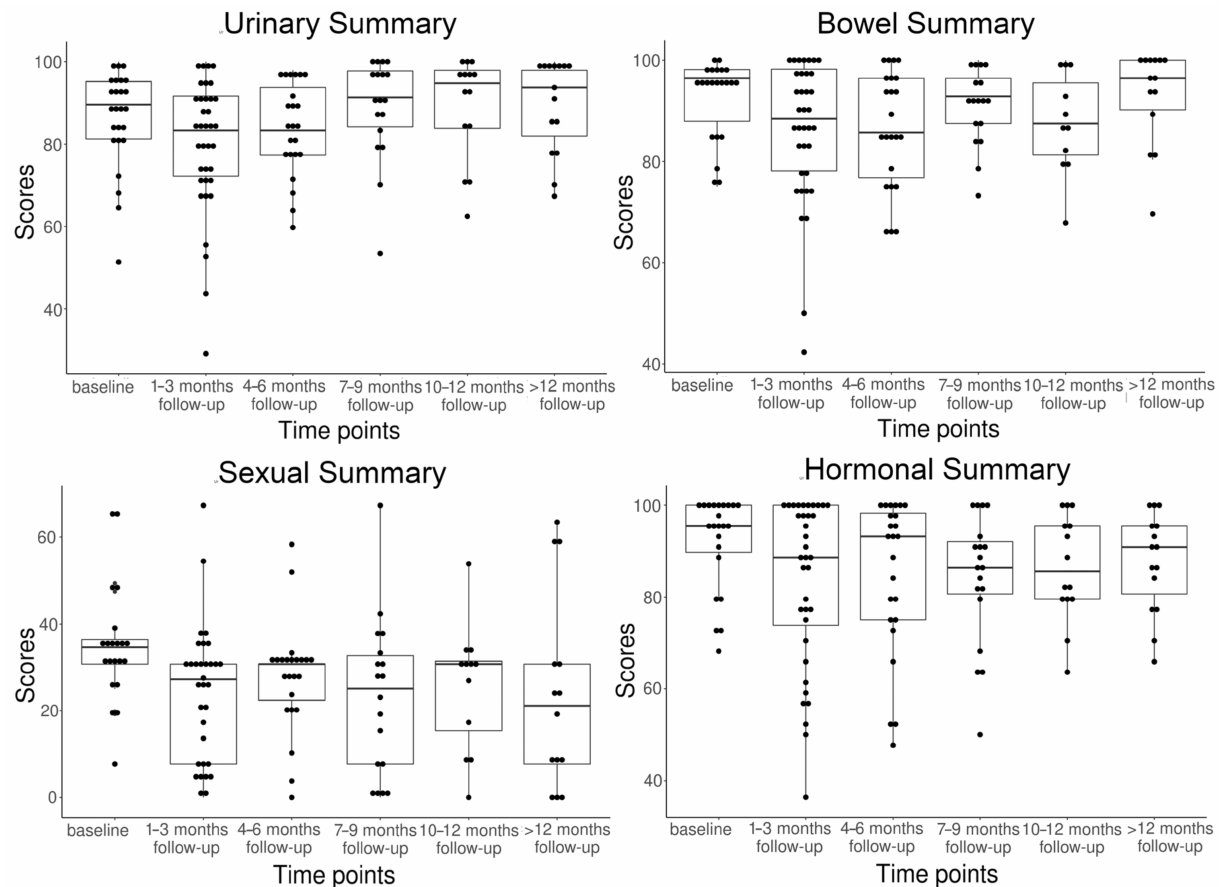
Figure 2. Longitudinal changes in Expanded Prostate Cancer Index Composite (EPIC) domain summary scores during the follow-up